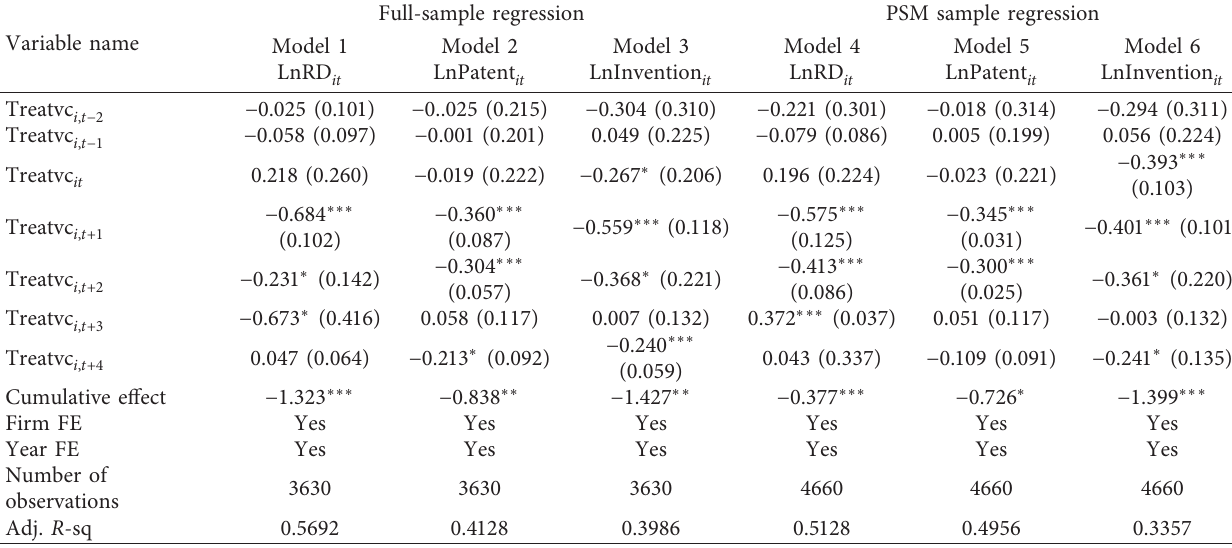
Table 2: Regression results: impact of VCs on the innovation level of their portfolio firms.